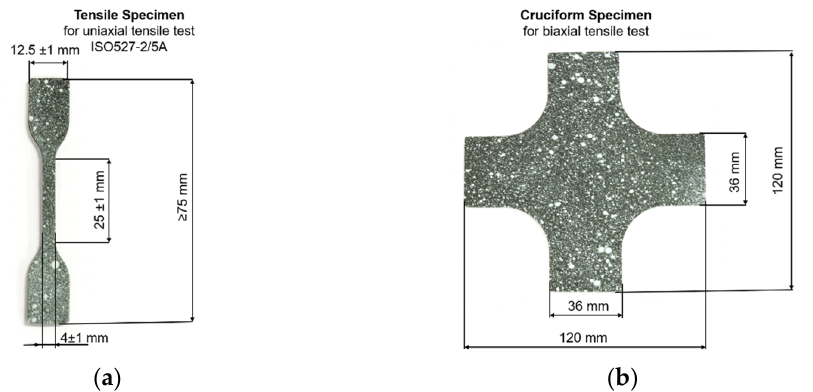
Figure 14. Specimens for hyper- and viscoelastic characterizations ( a ) ISO-5A tensile specimen; ( b ) cruciform specimen for in-plane biaxial tension tests. Both specimens were coated with speckle patterns for full field strain analyses.